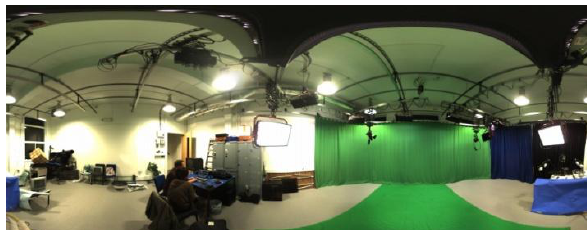
Figure 18 A spherical view of a green screen studio, created using Ladybug